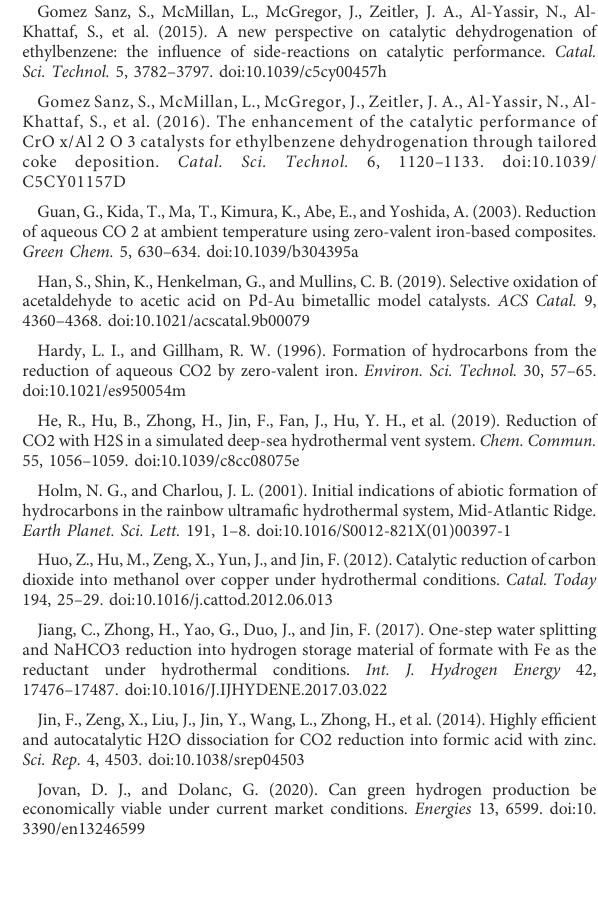
SUPPLEMENTARY TABLE S1 CO 2 conversion and gas phase composition at different reaction times.